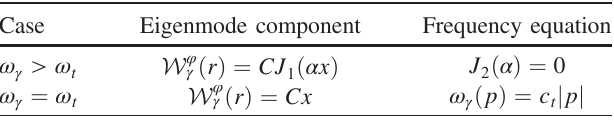
TABLE XII. Torsional (T) fiber eigenmodes: Nonzero compo- nent of the displacement eigenmode and frequency equations. The amplitude C ∈ C is fixed by the normalization condition Eq. (C14). All quantities are defined in Table IX.